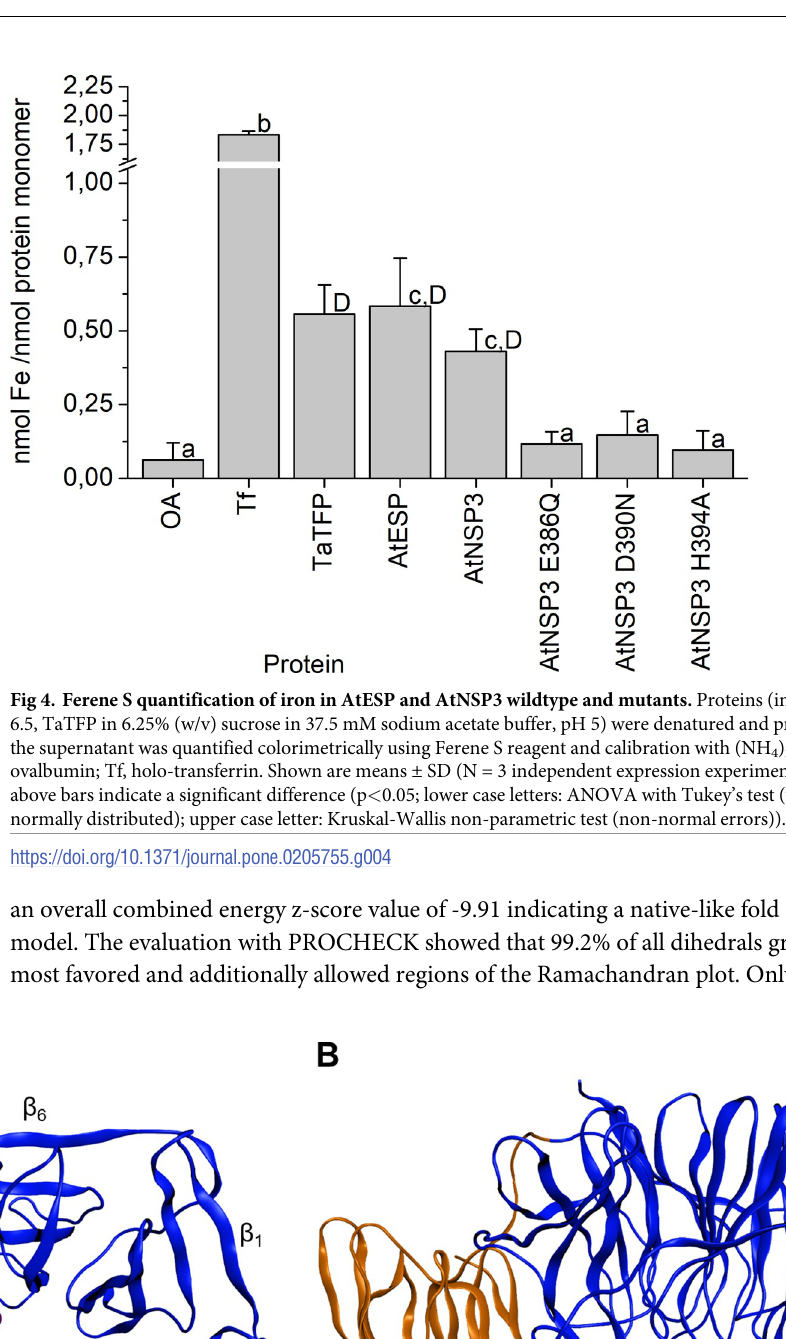
Fig 5. Structure of the final AtNSP3 homology model. The β -propeller and JAL domains are shown in blue and orange, respectively. Fe 2+ is represented by a purple sphere. (A) Top view. β -Sheets are labeled according to [34]. (B) Side view.